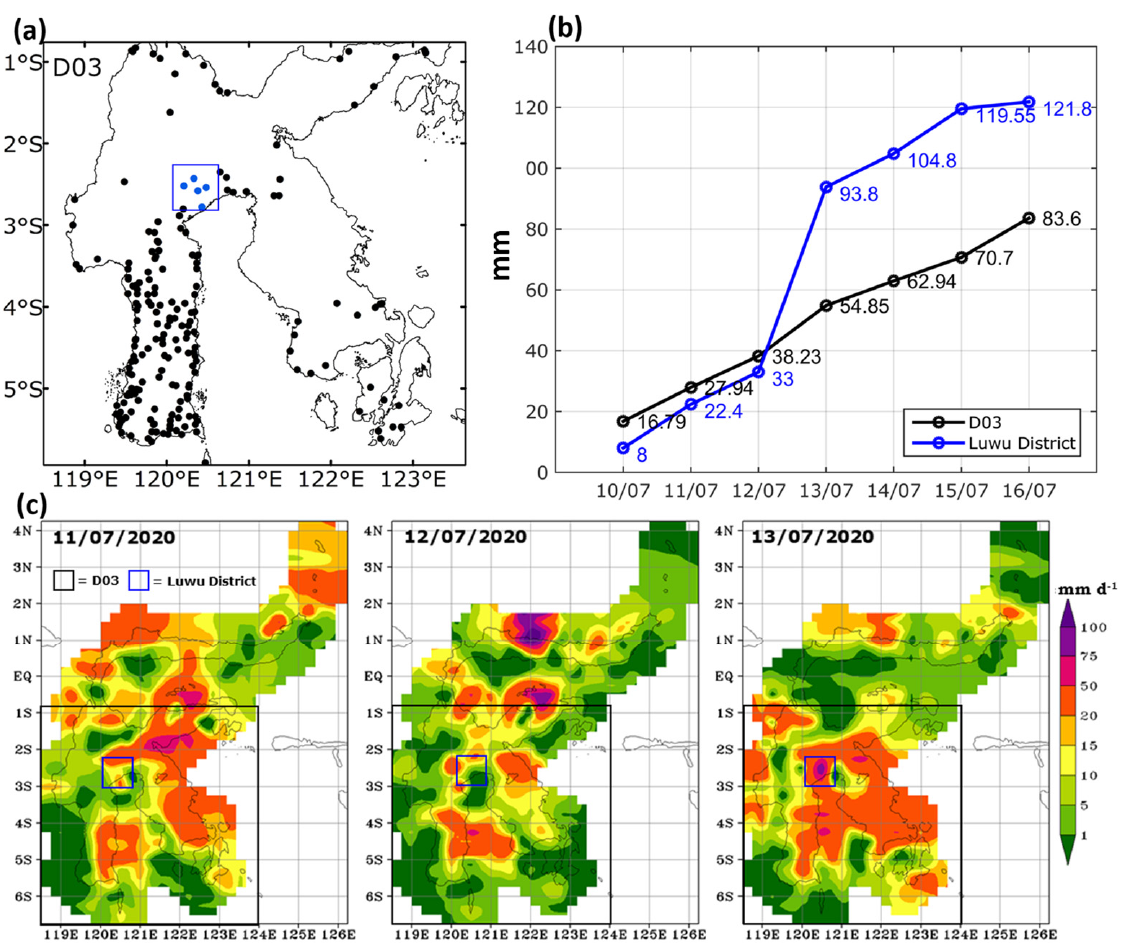
Figure 2. ( a ) Map of the BMKG station locations over Sulawesi Island. ( b ) Cumulative rainfall amount recorded at Luwu BMKG stations (blue line) and average cumulative rainfall amount computed on the D03 domain (black line) from 10 to 17 July 2020. ( c ) Spatial map of the interpolated cumulative daily rainfall data from several BMKG stations.